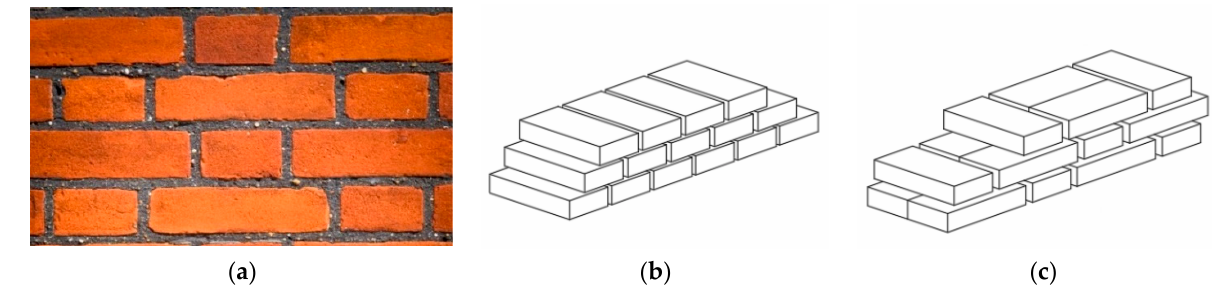
Figure 3. ( a ) Example of regular masonry texture; ( b ) texture with units in the same direction; ( c ) texture with units in two directions.